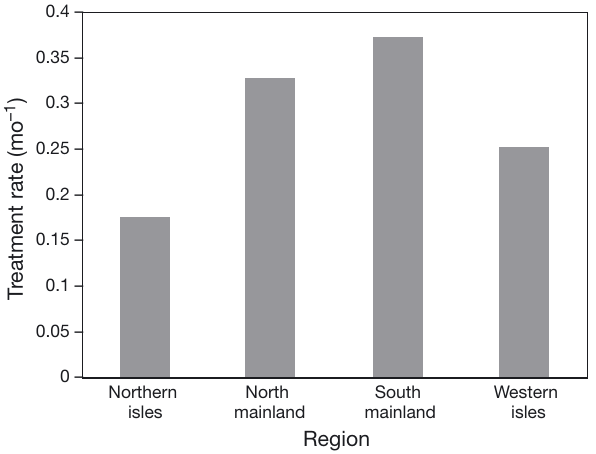
Fig. 5. Sea lice monthly treatment rates by region (regions as defined in Fig.